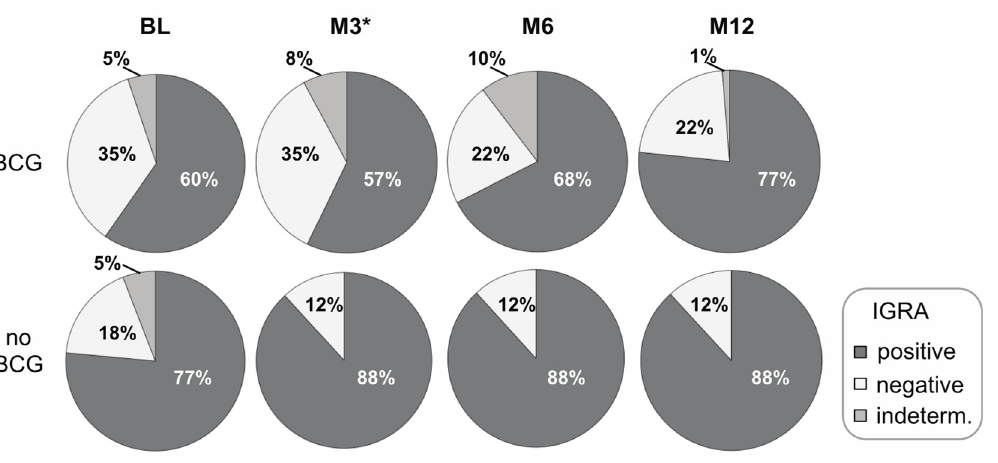
Figure 1. Time course comparison of BCG-vaccinated and non-BCG-vaccinated children with con fi rmed contact of tuberculosis patients for IGRA test results. Blood samples of contacts from tuberculosis index patients classi fi ed as either BCG-vaccinated ( n = 77) or non-BCG-vaccinated ( n = 17) compared for positive, negative, or intermediate IGRA results are shown as pie charts for four timepoints (i.e., BL, M3, M6, M12). The Fisher exact test was applied to analyze signi fi cance of di ff erences between the study groups for individual timepoints. A p -value of <0.05 was considered signi fi cant and is indicated by *. indeterm., indeterminate.